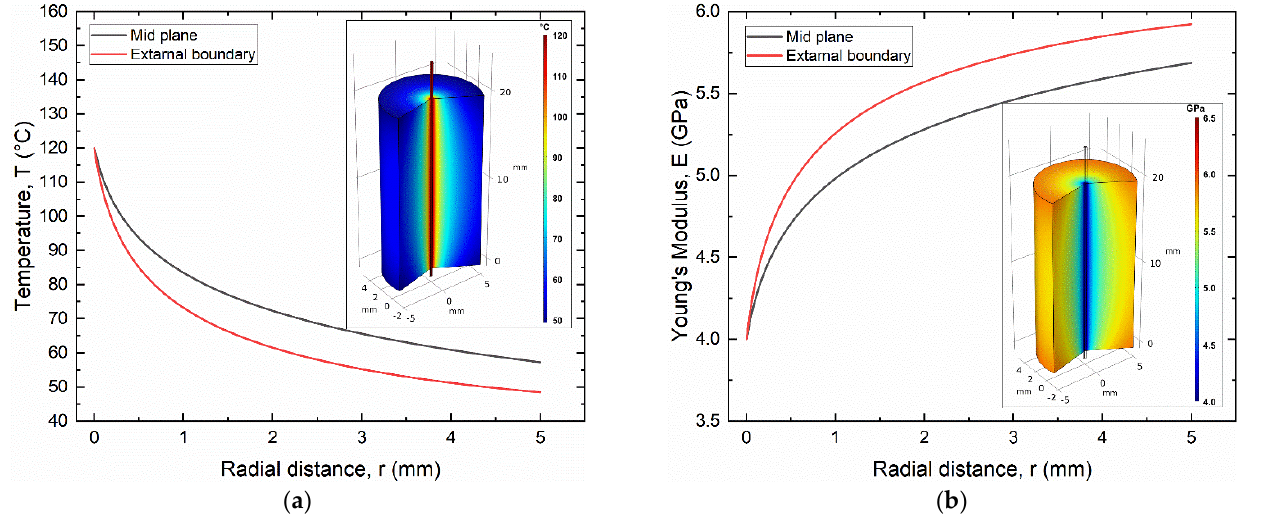
Figure 12. Finite element results of as manufactured samples subjected to mechanical loading and thermal activation of the SMA wire (load case #2): ( a ) temperature distribution in the resin block; ( b ) Evolution of the Young’s modulus in the resin